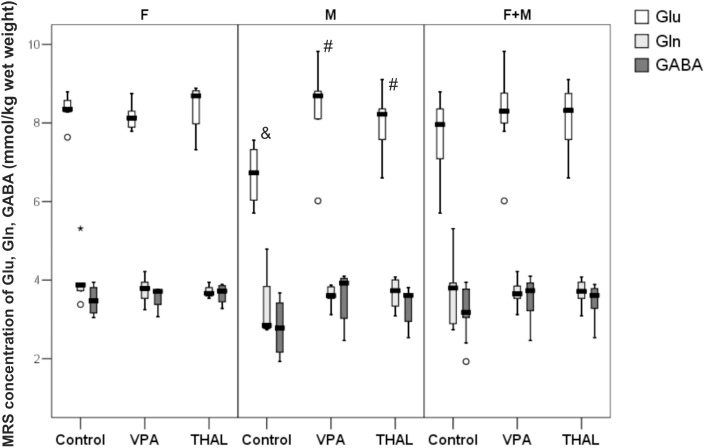
Box and Whiskers plot of changes in Glu, Gln, and GABA levels in rat hippocampus measured in vivo using MRS method. The obtained results are expressed in mM/kg wet weight). Results that are statistically significant vs. control are represented by # and within a group between genders by &, p < 0.05. Number of rat pups: n = 10 (control), n = 11 (VPA), and n = 13 (THAL); # represents results statistically significant vs. control, p < 0.05, one-way ANOVA followed by Dunn’s correction; box containing 50% of results that fell in the range between 25% (bottom line) and 75% (top line), () median value,  – outlier point per rat, ∗ – extreme outlier point per rat.